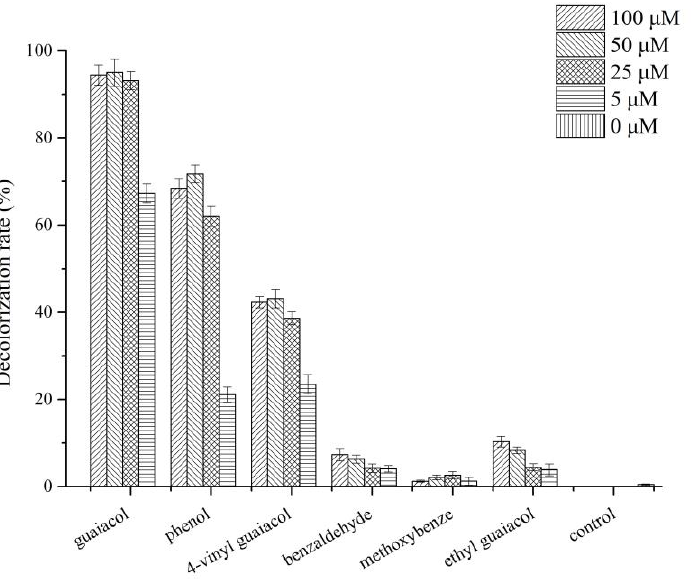
Figure 6. Evaluating lignin-derived compounds based on decolorization of DR5B within 1 h. Decol- orization of DR5B (100 mg L − 1 ) within 1 h with purified laccase (final concentration: 1 U mL − 1 ) and intermediators (0, 5, 25, 50, and 100 µM).